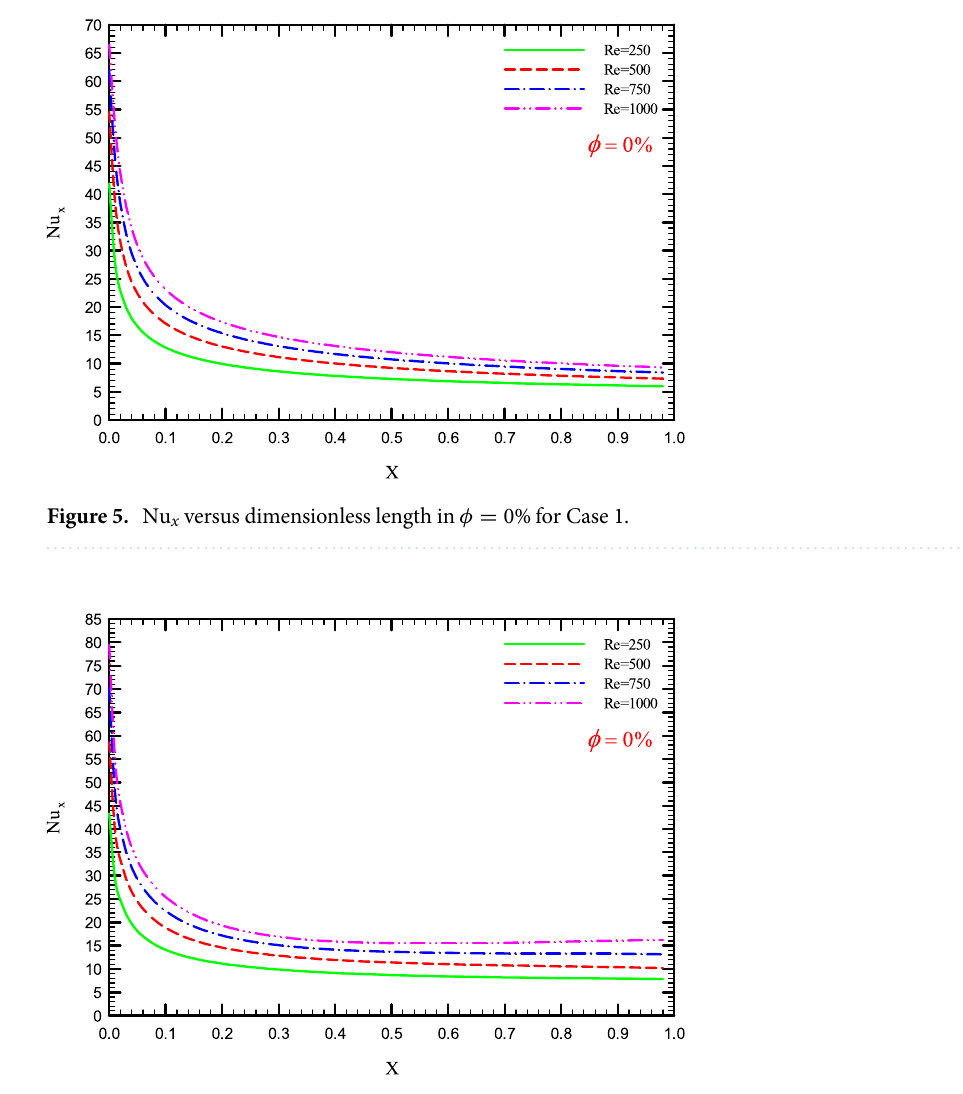
Figure 6. Nu x versus dimensionless length in φ = 0% for Case 2.